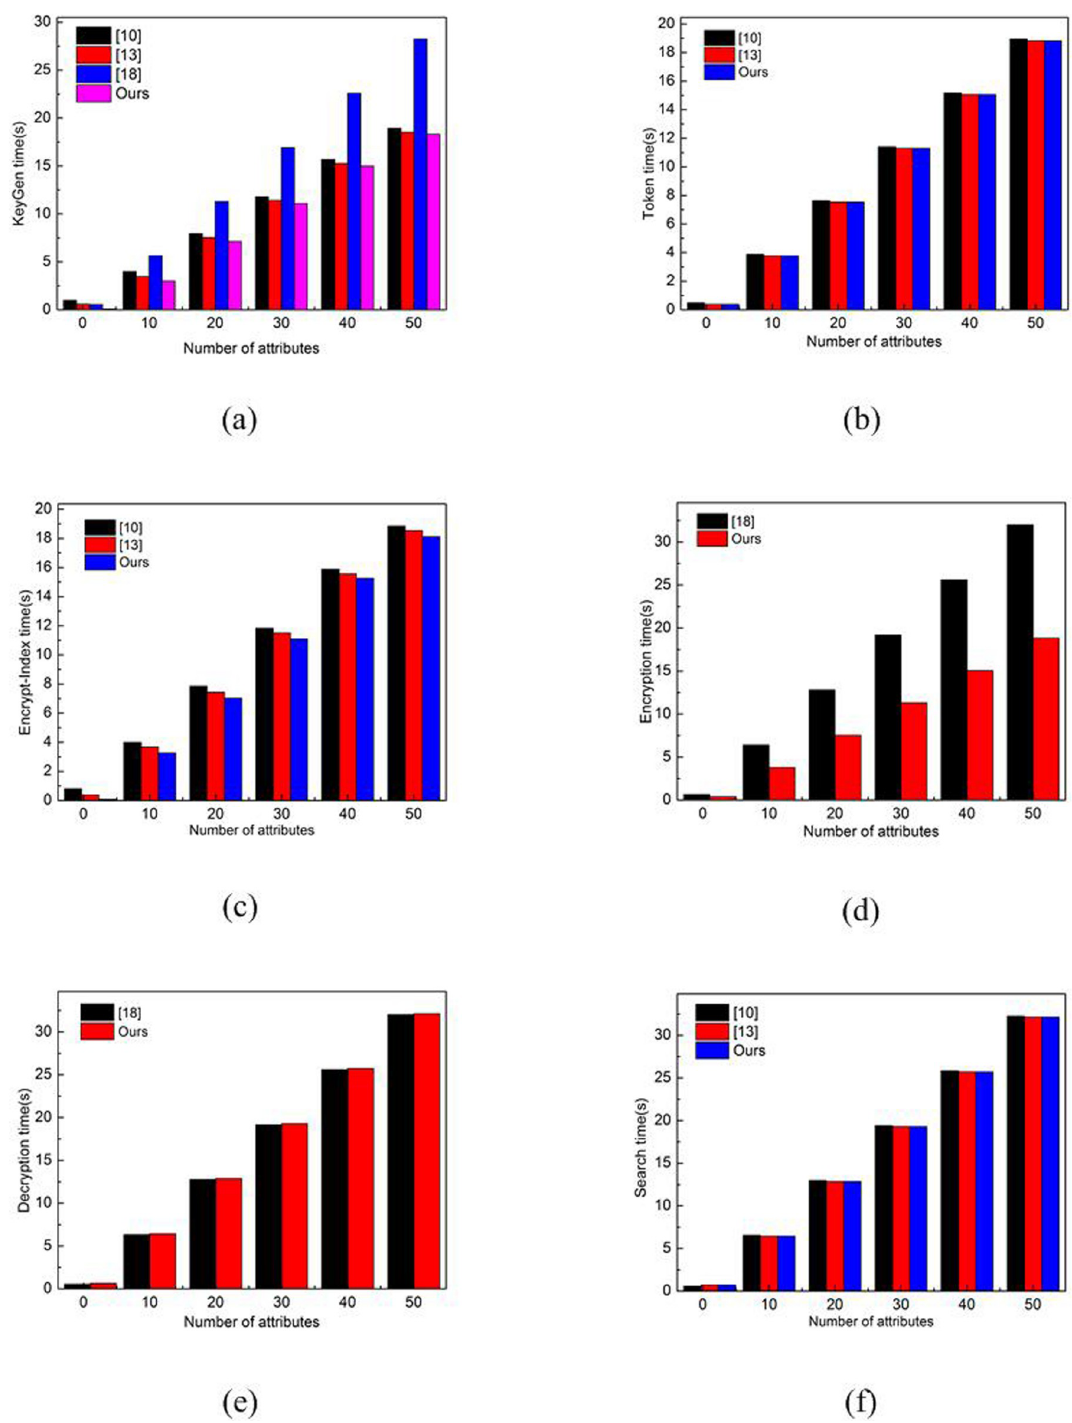
Fig 2. Computation